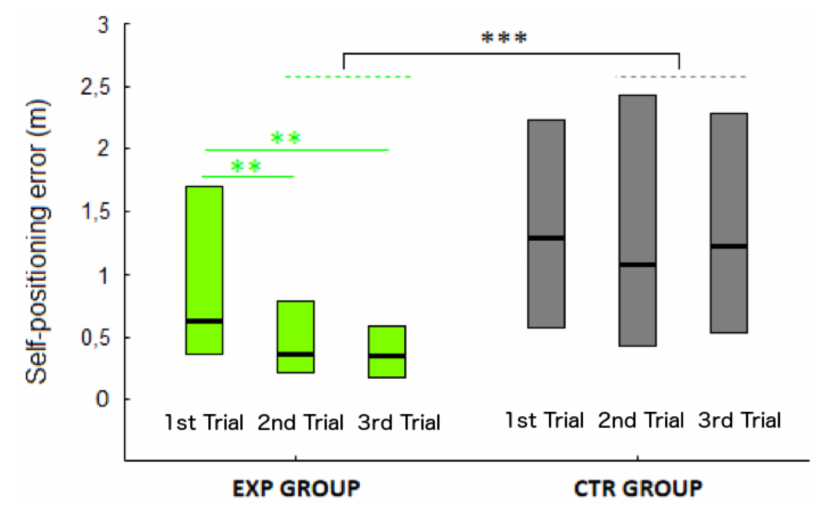
Figure 4. Self-positioning error (m) for each trial in the feedback group (green bars) and in the no-feedback group (grey bars). Green asterisks indicate a significant reduction of the self-positioning error in the 2nd and 3rd trial in the experimental (EXP) group. Grey asterisks indicate a significantly larger self-positioning error in the 2nd and 3rd trial in the control (CTR) compared to the EXP group. **, p < 0.01; ***, p < 0.001.